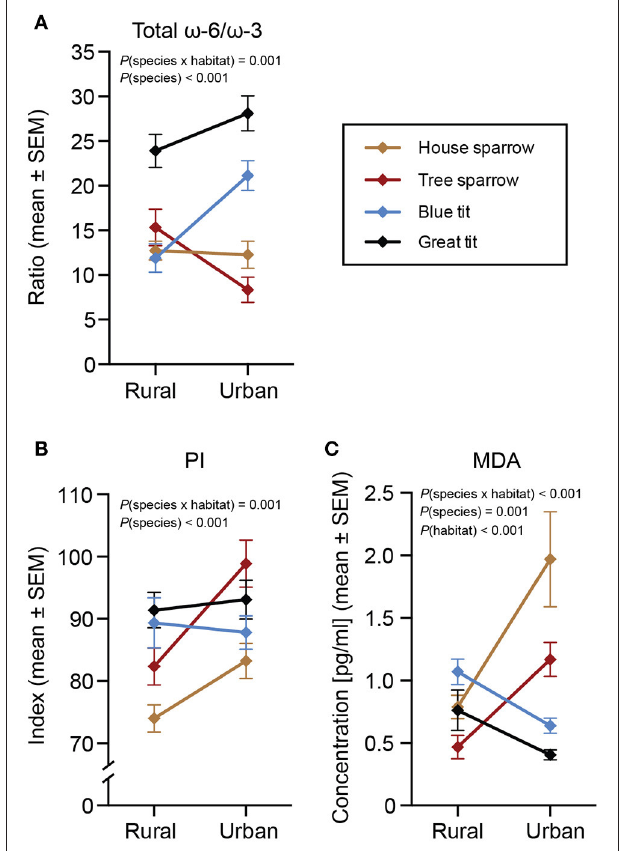
FIGURE 4 | Biomarkers of health in four species of passerines from urban and rural environments. (A) Total ω -6/ ω -3 polyunsaturated fatty acids (PUFA) ratio, (B) peroxidation index (PI), and (C) lipid peroxidation (MDA). Data are plotted as means ± standard error of the means (SEM). Note the different scales on the y -axes. Significant effects of species, habitat and/or the habitat × species interaction are indicated by the P- values. The n -values for (A,B) are presented in Table 1 . The n -values for MDA (C) were: house sparrow urban = 24, house sparrow rural = 24; tree sparrow urban = 12, tree sparrow rural = 44; blue tit urban = 32, blue tit rural = 30; great tit urban = 34, great tit rural = 29.